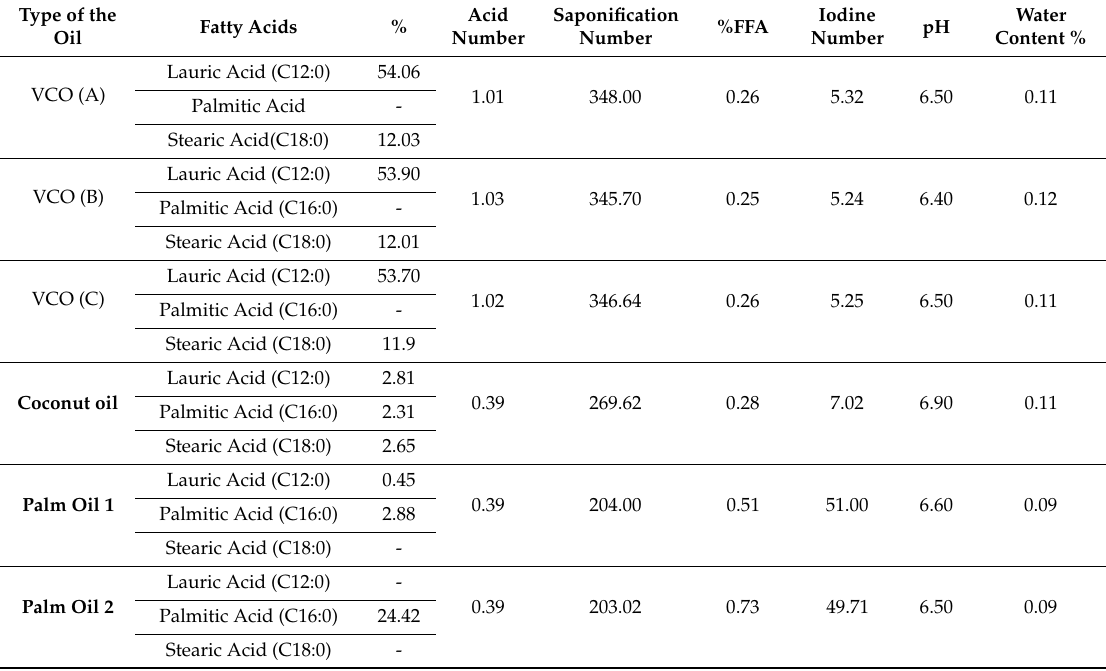
Table 1. The results: Composition and properties of virgin coconut oil, coconut oil and palm oil. Type of the